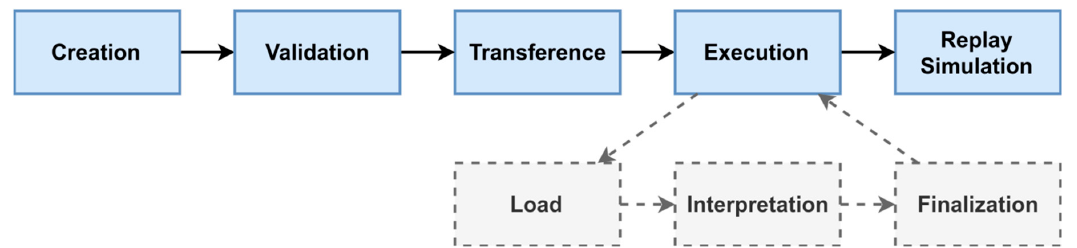
Figure 1. Mission life cycle stages.